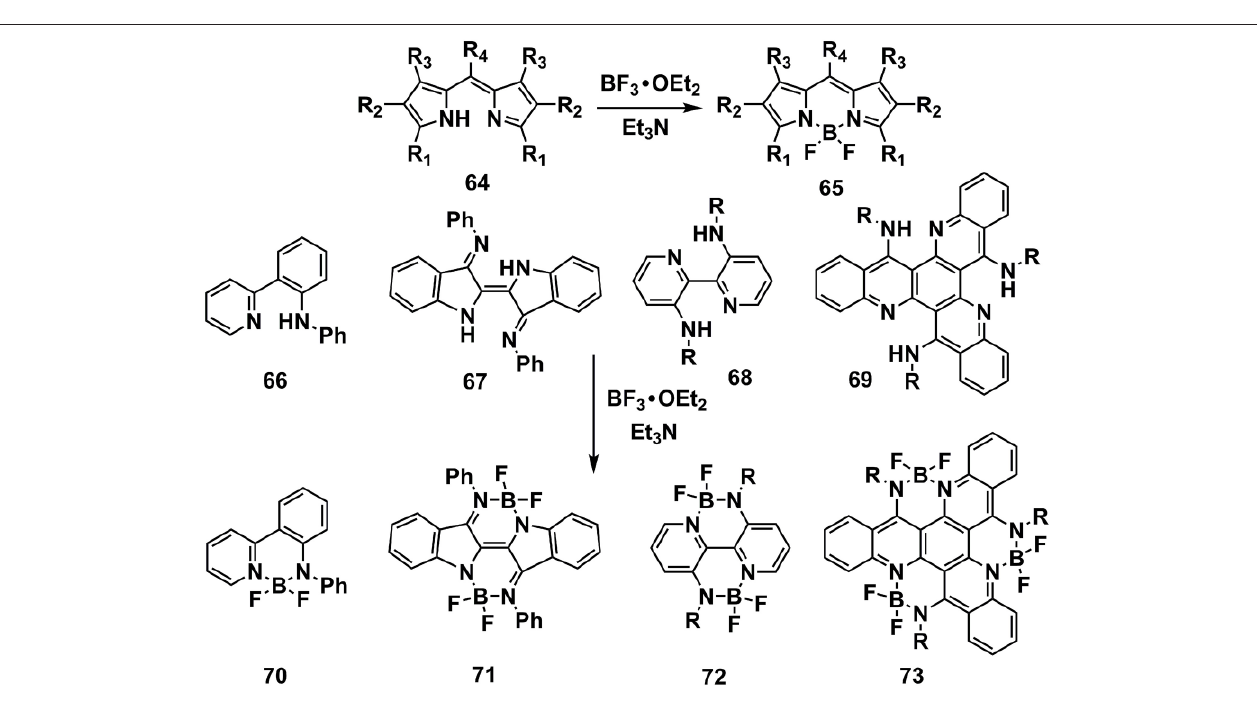
FIGURE 7 | Examples of synthesis routes toward π -units containing N-B ← N groups via BF 3 • OEt 2 /Et 3 N reaction